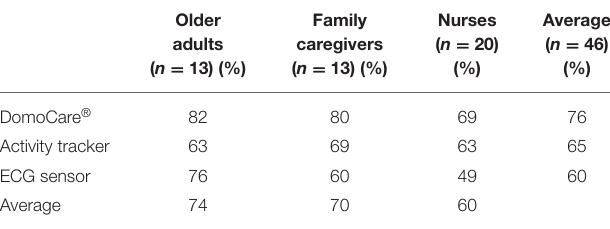
TABLE 2 | Opinion on the usefulness of ambient (DomoCare ® ) and wearable sensors (Activity tracker, ECG) to help staying at home, improving home care, improving quality of life, preventing domestic accidents, or reducing family